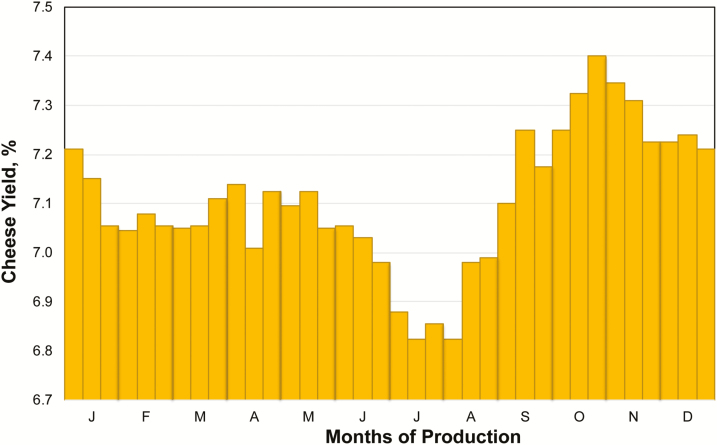
Month of production and Grana Padano cheese yield (%; Mariani et al., 1995).